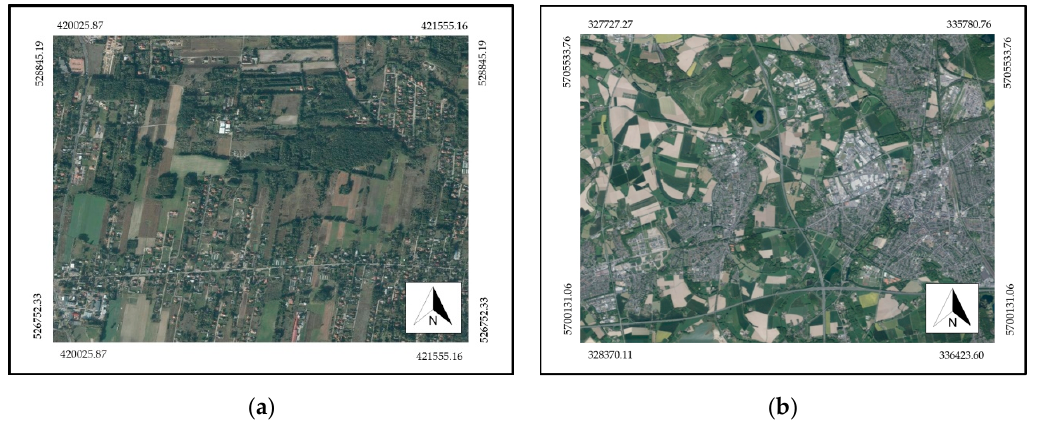
Figure 9. Suburbanization zones in ( a ) the city of Ł ód ź (Poland) and ( b) the city of Cologne (Germany). Source: own study [54].